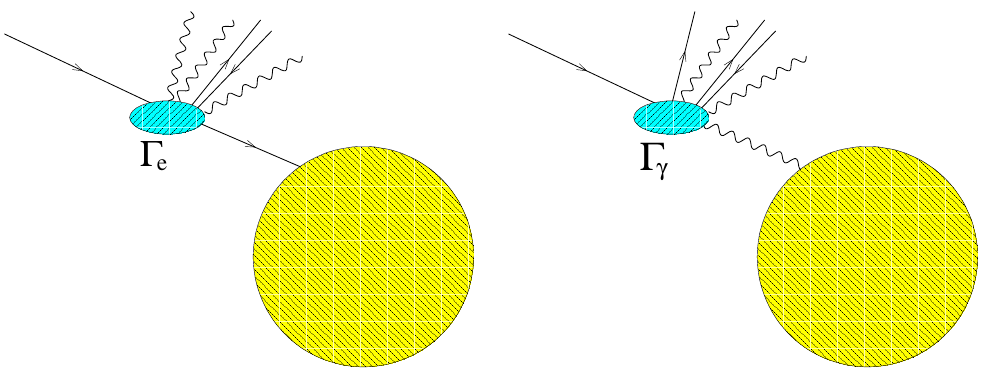
Figure 1 . Electron (left panel) and photon (right panel) PDFs (blue ellipses) in an electron. The full yellow circle represents a generic short-distance